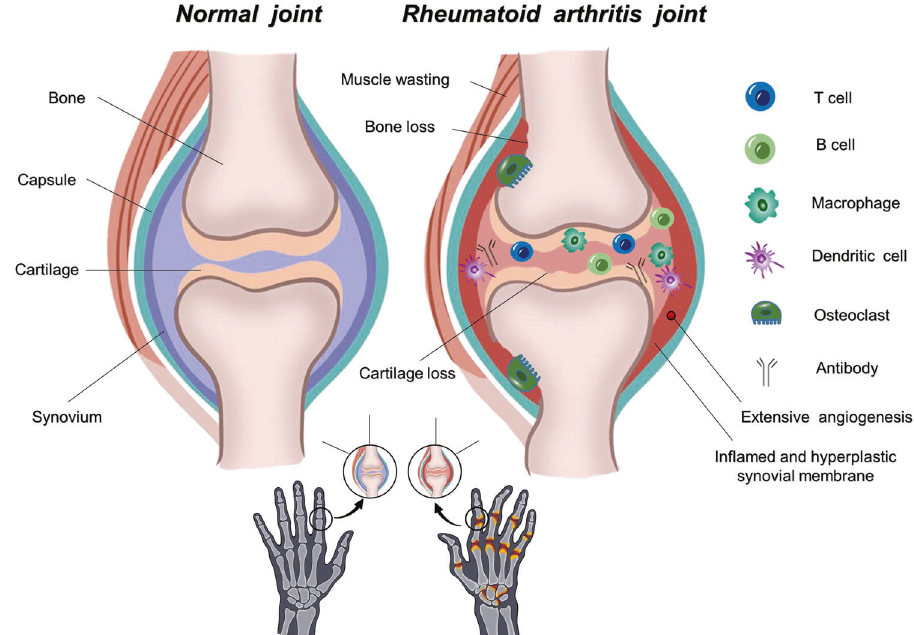
Fig. 3 Normal and rheumatoid arthritis joints. Joint swelling in RA re fl ects synovial in fl ammation due to immune activation. The cellular composition of RA synovitis is characterized by the accumulation of innate and adaptive immune cells (e.g., T cells, dendritic cells, B cells, macrophages, and osteoclasts). Pro-in fl ammatory and bone-destructive factors of the immune response led to the loss of bone or cartilage with synovial thickening, angiogenesis, and muscle